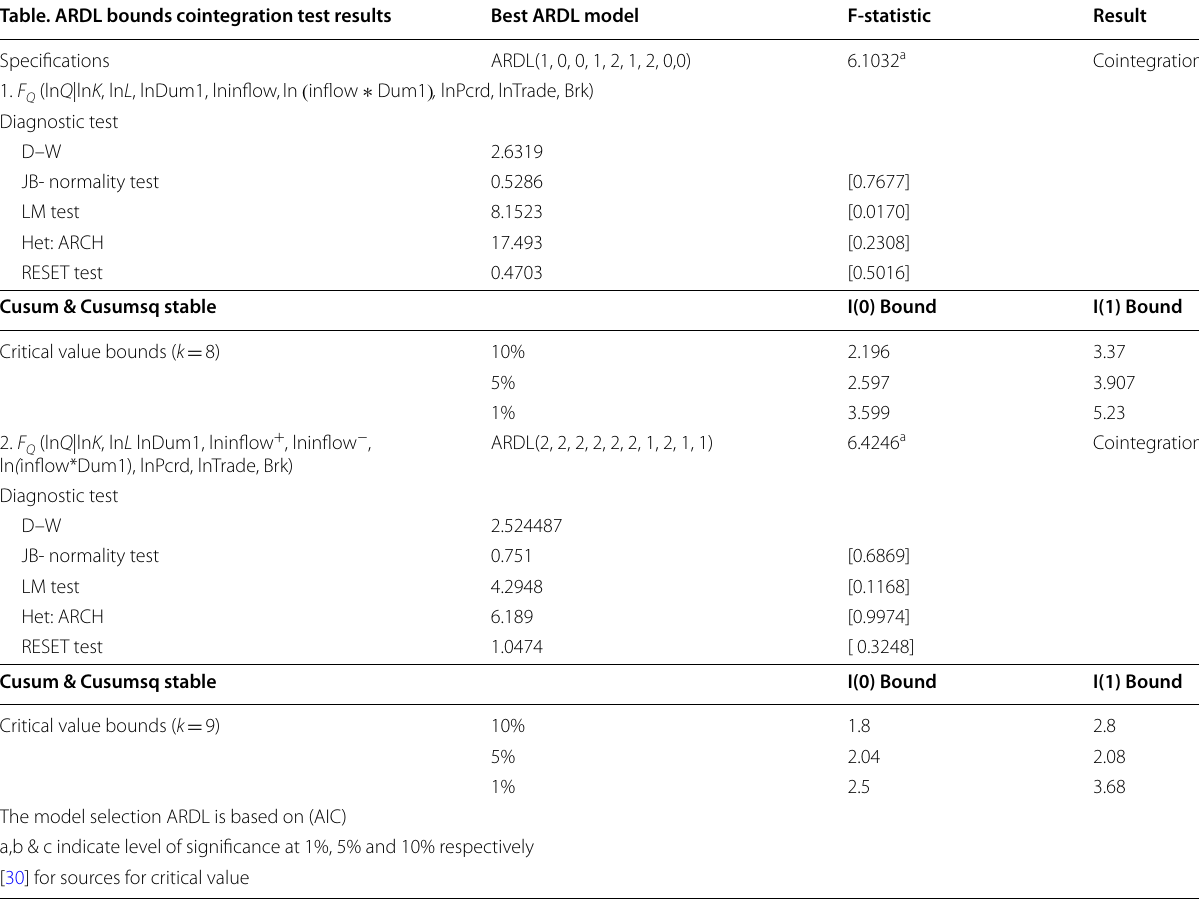
Table 3 FDI-inflow for symmetric and asymmetric ADRL bounds co-integration test Table. ARDL bounds cointegration test